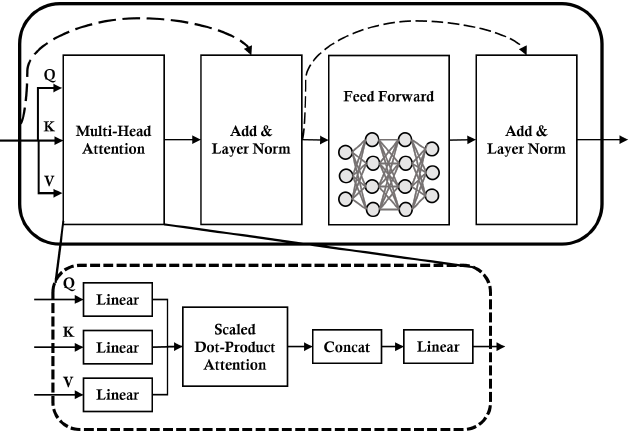
Figure 5. Architecture of Transformer encoder and multi-head